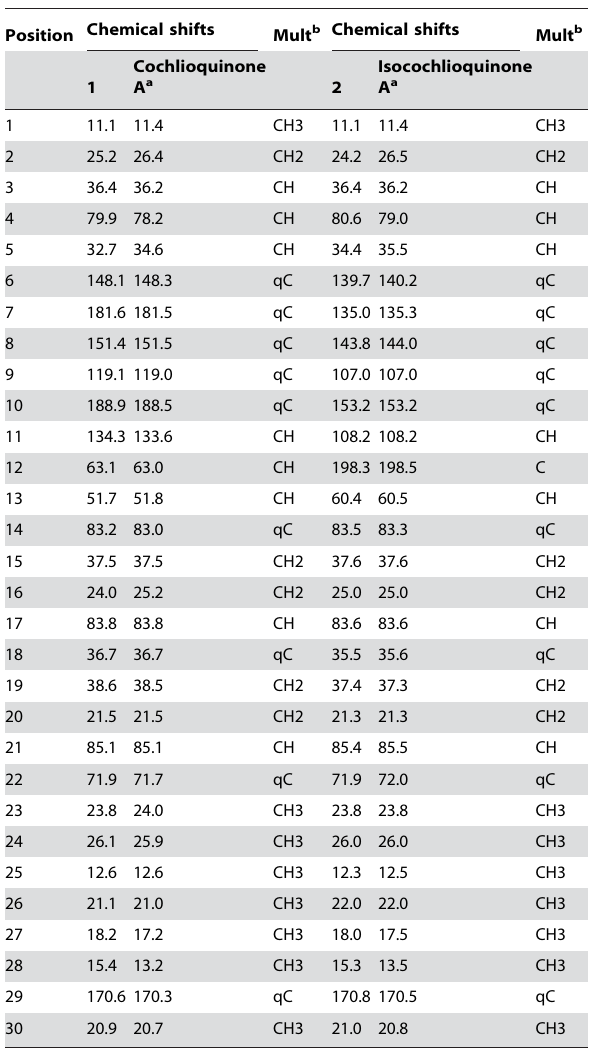
Table 4. 13 C-NMR and DEPT spectral data of compounds 1 and 2 and comparison with literature data for Cochlioquinone A and